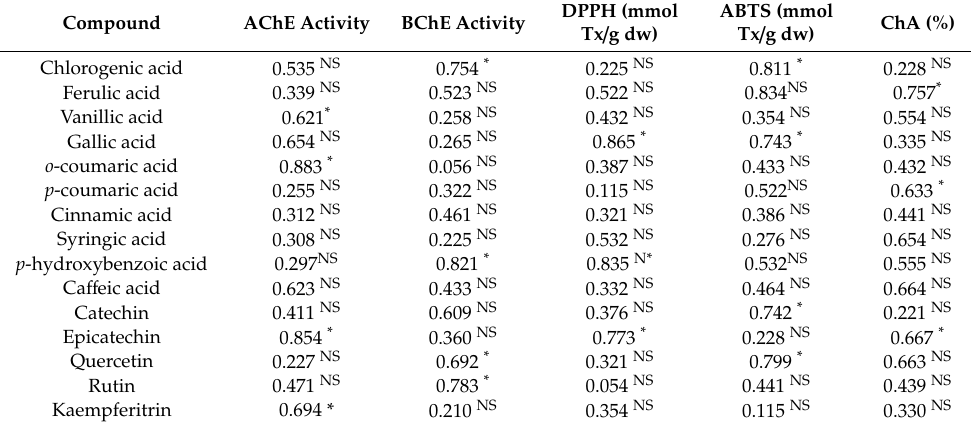
Table 3. Correlation coe ffi cients between AChE and BChE and estimated components in Humulus lupulus hops extracts.